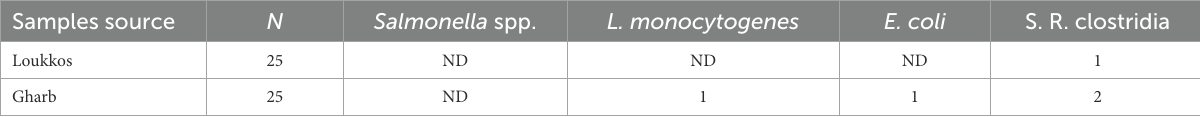
TABLE 2 Occurrence of Salmonella spp., Listeria monocytogenes , Escherichia coli , and Sulfite-reducing clostridia spores in strawberry samples. Samples